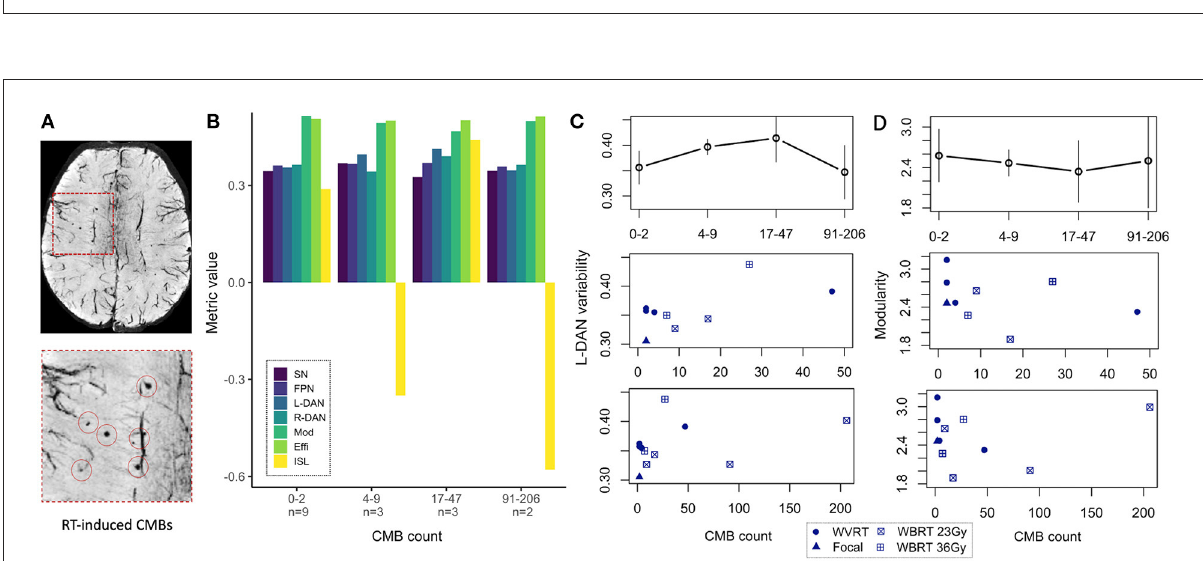
FIGURE6 MR metrics change parabolically with increasing CMB burden. Degree of cerebral microbleed (CMB) burden detected on SWI (A) reveals parabolic-like changes in left hemisphere dorsal attention network (L-DAN) variability and modularity (B) with increasing CMB burden (based on within-group averages). Isolated plots for L-DAN variability and modularity are shown respectively in the top row of (C, D) ; the bottom rows show the individual patient data points for CMB counts ranging 1–50 (magnified) and 1–205 (full range). In (B) , modularity values have been reduced by a factor of 5 for visualization purposes. Two of the 19 patients had poor SWI data quality and therefore CMB burden could not be evaluated. SN, salience network; FPN, frontoparietal network; L-DAN, left hemisphere dorsal attention network; R-DAN, right hemisphere DAN; Mod, modularity; Effi, efficiency; ISL, International Shopping List test